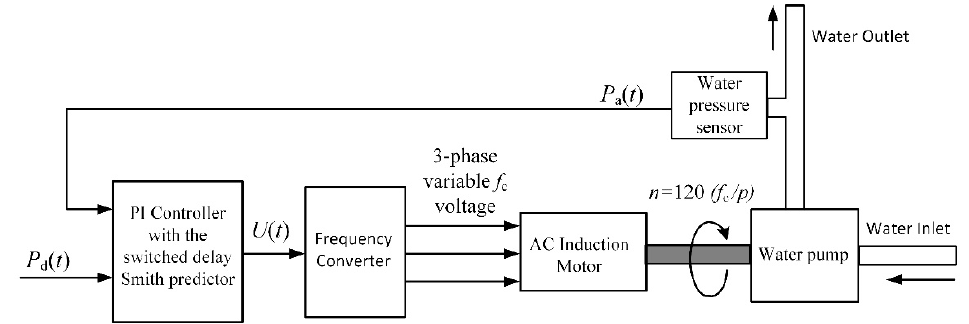
Figure 13. Block diagram of the water-supply control system based on the variable speed AC induction motor drive implemented using frequency converter. P d ( t ) is the desired and P a ( t ) is the actual water pressure, f c is the frequency of 3-phase voltage generated by the frequency converter, n is the motor-rotation speed, p is the number of motor poles.